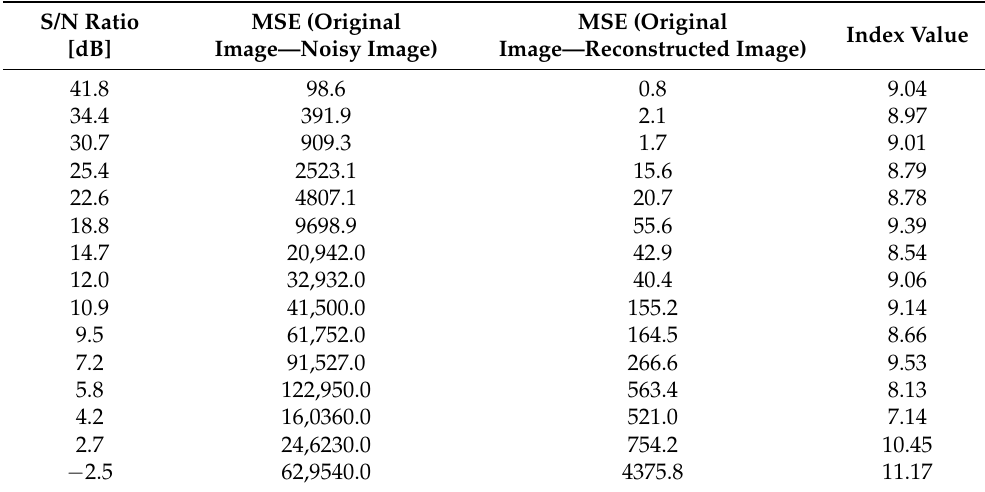
Table 4. Mean squared error of reconstruction.